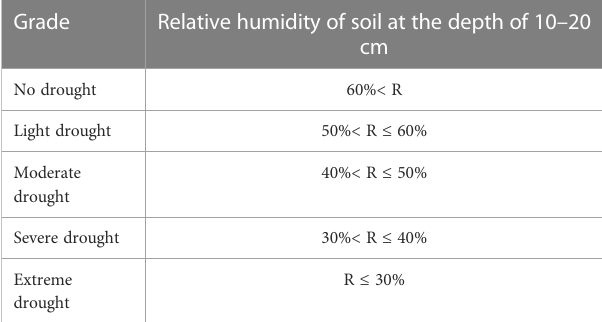
TABLE 1 Classi fi cation standard of drought grade. Grade Relative humidity of soil at the depth of 10 – 20